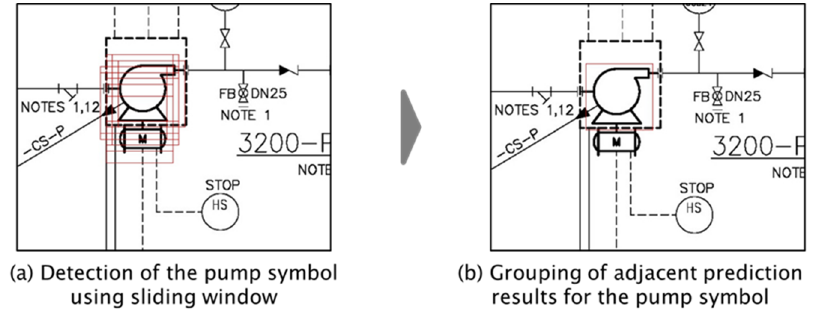
Figure 8. Grouping of predicted results for the symbol.